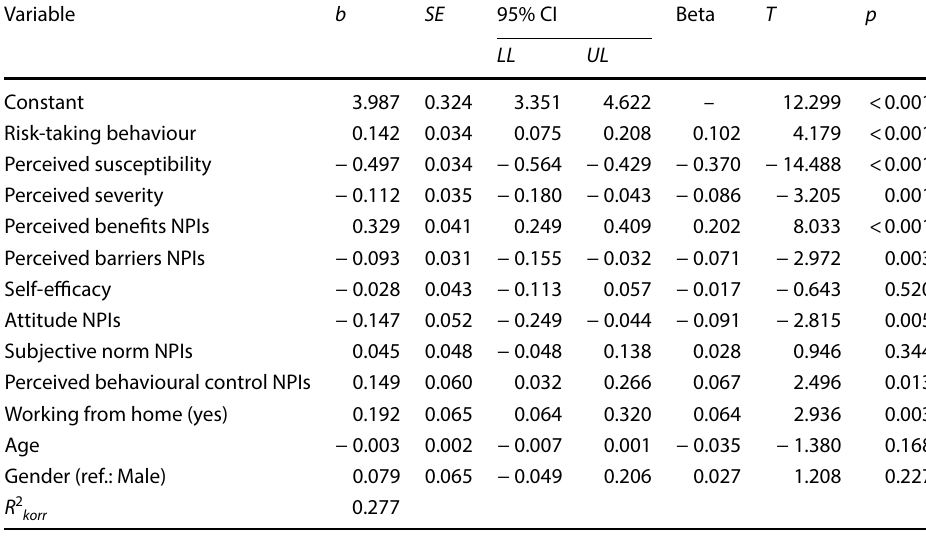
Table 5 Results of the multiple regression